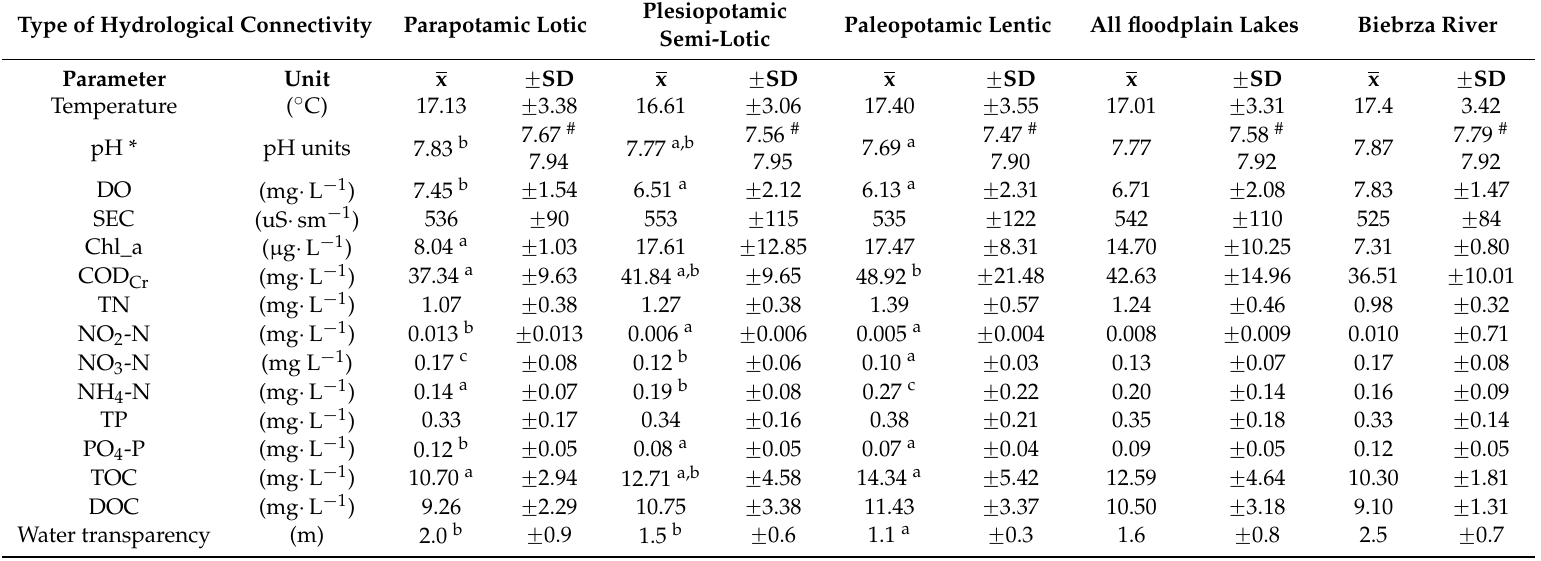
Table 2. Water quality parameters of the studied floodplain lakes (mean ˘ SD). Values followed by different superscripts ( a , b , c ) in rows are significantly different among types of floodplain lakes in Duncan's multiple range test ( post-hoc , ANOVA; p ď 0.05). pH: * median; # Q 25 –Q 75